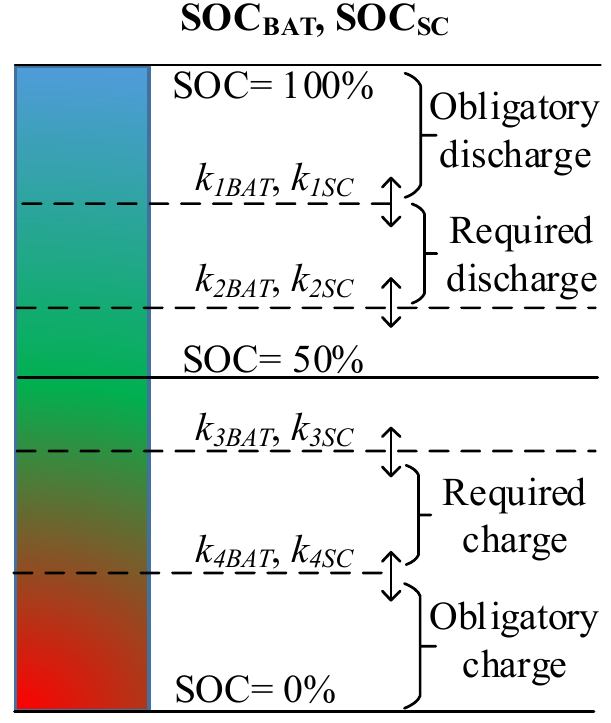
Figure 4. State of charge (SOC) intervals and corresponding energy management system (EMS) action.